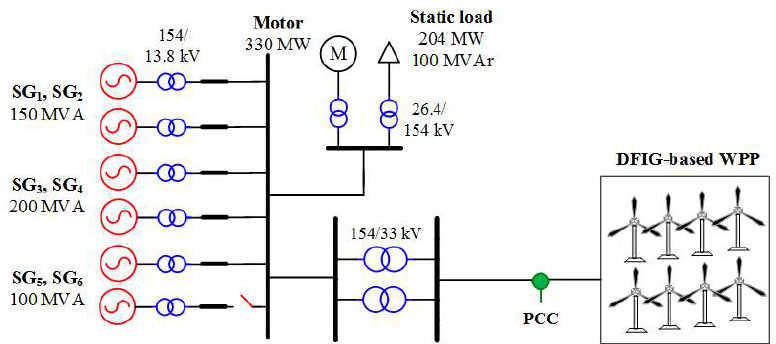
Figure 12. Single line model system with a DFIG-based wind